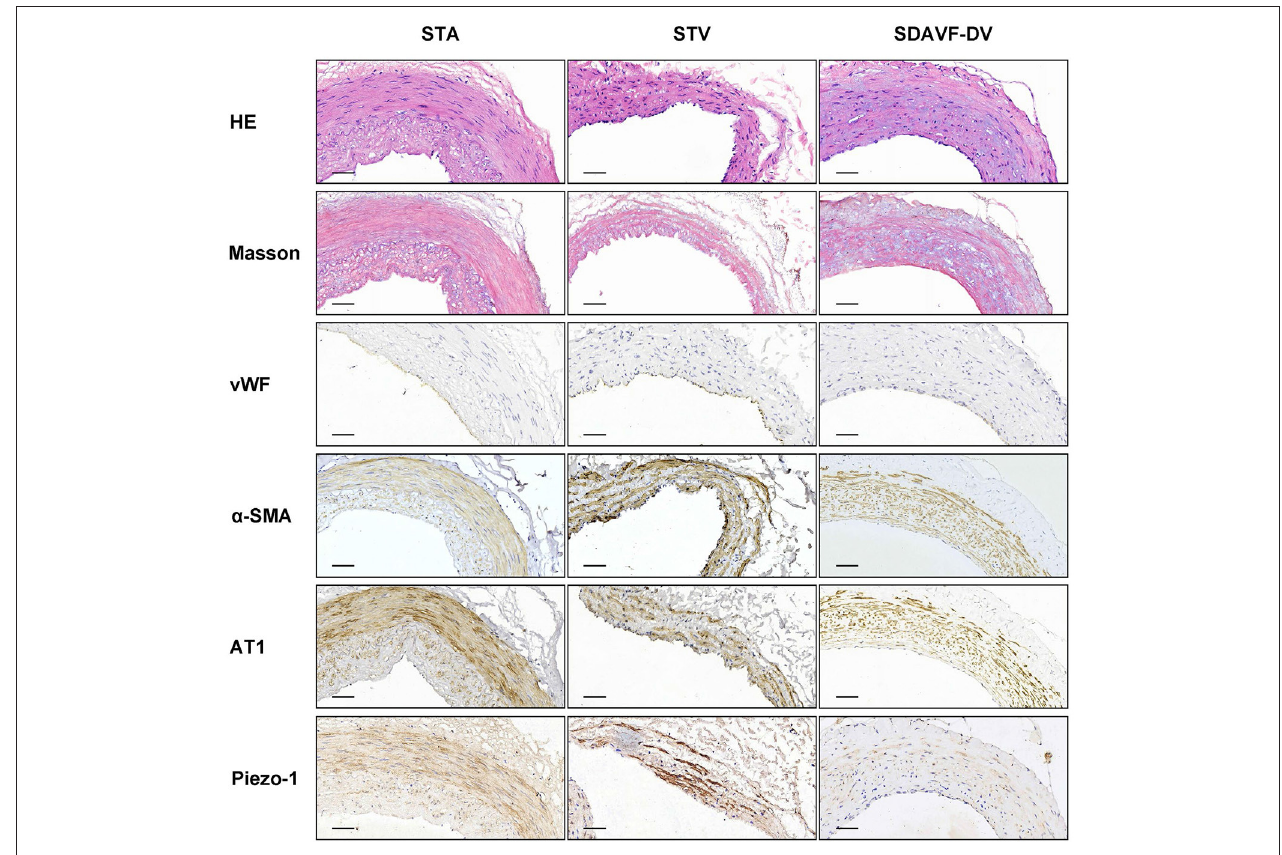
FIGURE 1 | HE staining, Masson’s trichrome staining, vWF, α -SMA, AT1 and piezo-1 immunohistochemistry. Histological features of the STA, STV and SDAVF-DV are shown in the photomicrographs. Representative photomicrographs showing HE-stained and Masson’s trichrome-stained vascular tissues are presented. vWF, α -SMA, AT1 and piezo-1 were detected by immunohistochemistry. Scale bar = 50 µ m in